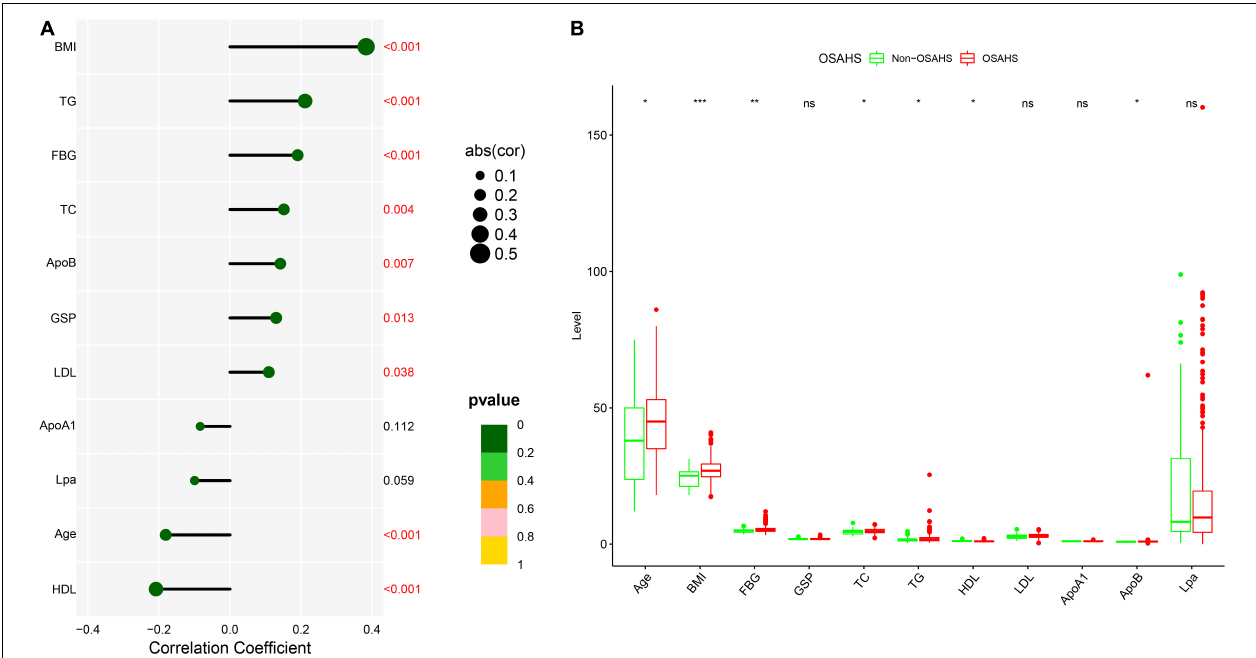
FIGURE 2 | Correlation and difference analysis of 11 clinical continuous indicators. (A) Correlation analysis between AHI and 11 continuous indicators. Different sizes and colors of circles represent different correlation coefficients and significance p -value, respectively. (B) Differences of 11 continuous indicators between OSAHS and non-OSAHS groups. Different symbols are shown at the top of the block diagram. ns: p > 0.05; * p < 0.05; ** p < 0.01; *** p < 0.001.